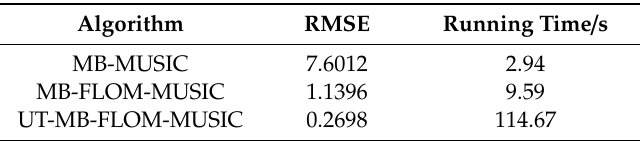
Table 1. Running Time (CV